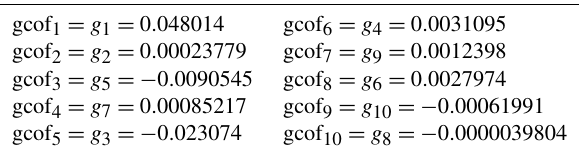
Table A2. Polynomial coefficients for d a # and depth. gcof 1 = g 1 = 0 . 048014 gcof 6 = g 4 = 0 . 0031095 gcof 2 = g 2 = 0 .